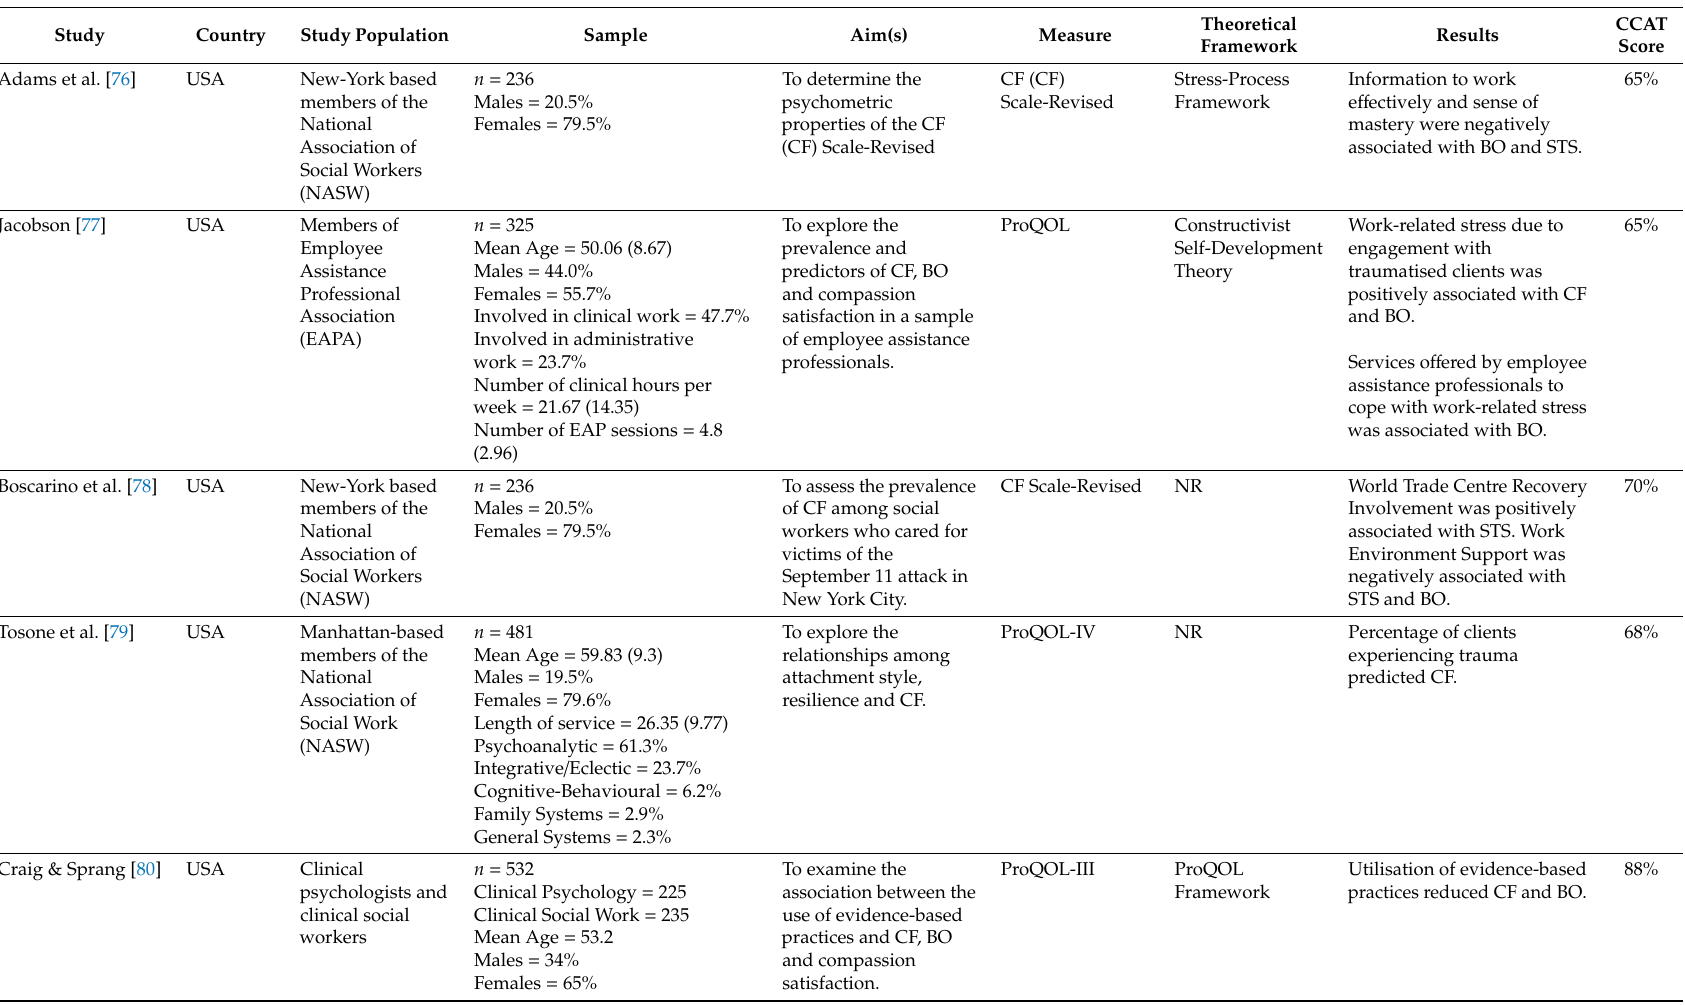
Table 1. Study characteristics and CCAT